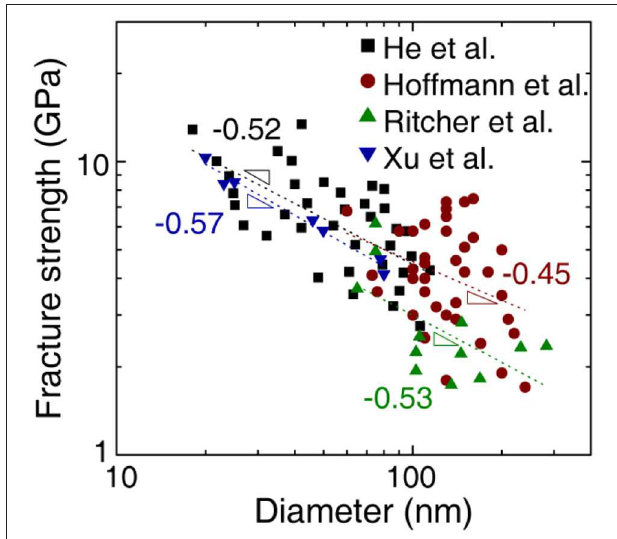
FIGURE 4 | Fracture strength vs. diameter plots from tensile experiments on the brittle ZnO (Hoffmann et al., 2007; Xu et al., 2010; He and Zhu, 2011) and Cu ( Richter et al., 2009)